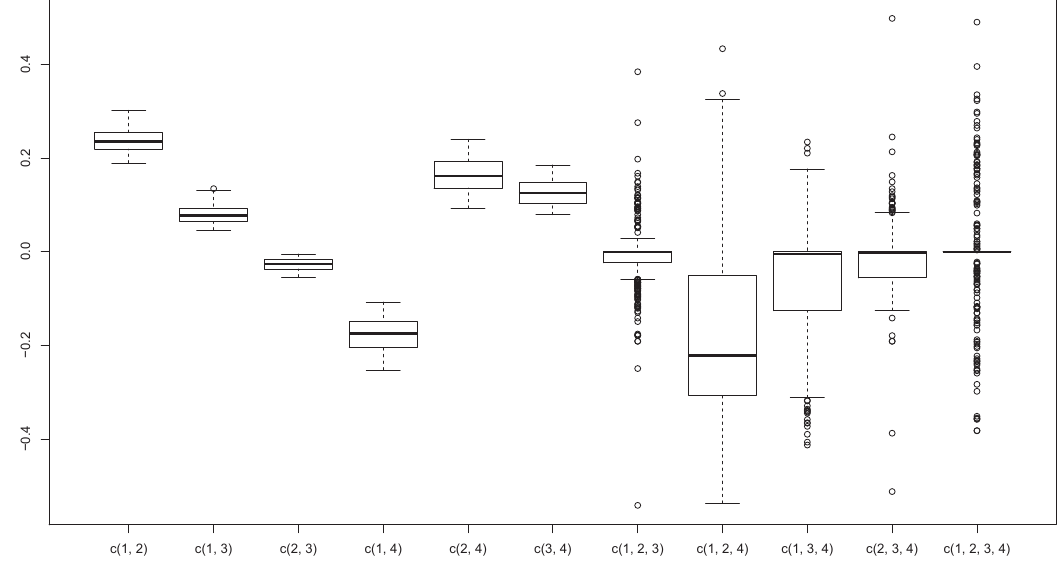
Figure 4. The box plot of Shapley indices of non-singletons with K =